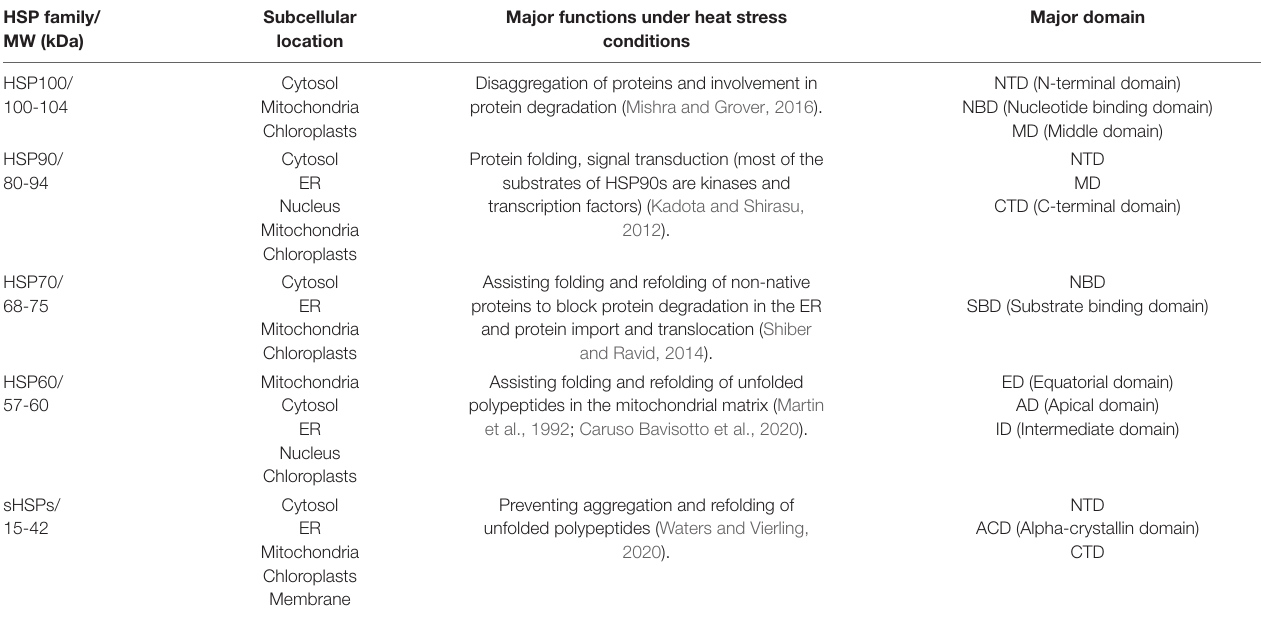
TABLE 1 | Five major families of heat shock proteins and their major function under heat stress